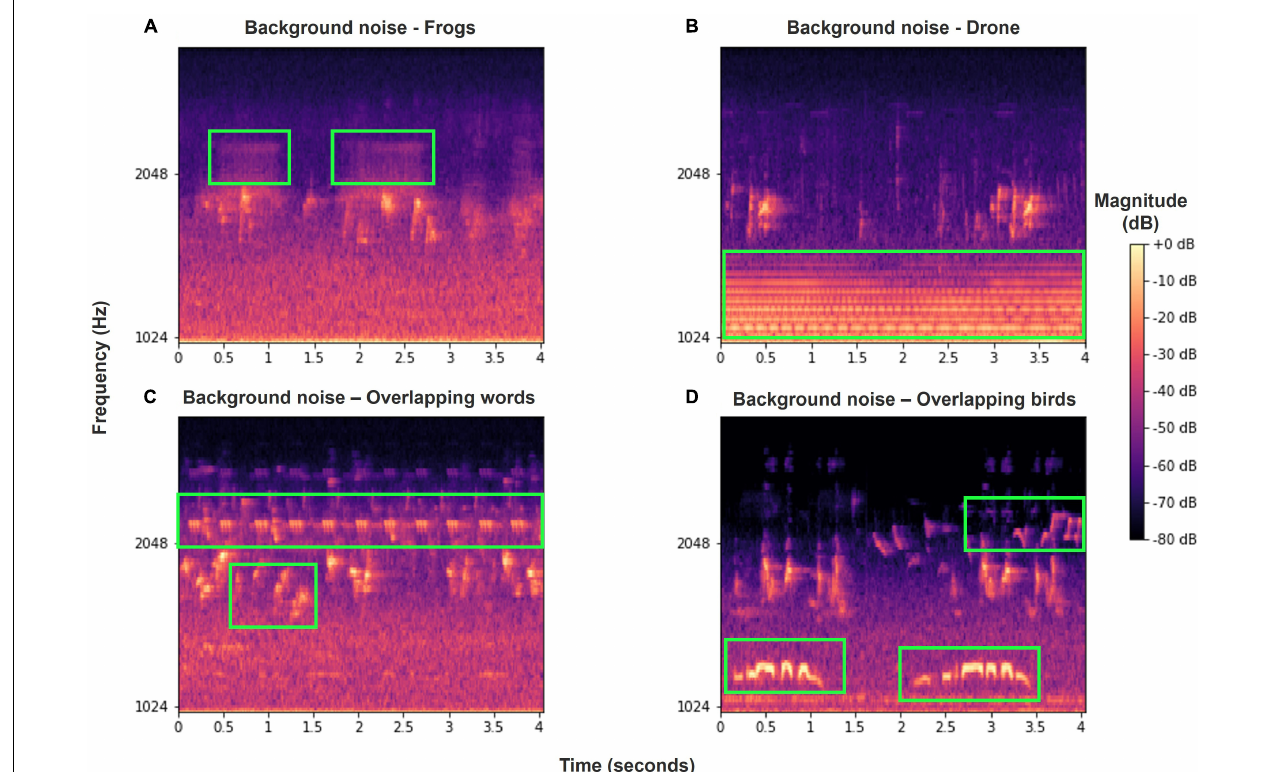
FIGURE 3 | Various examples of background noise or overlapping Bulbul calls in our recordings, marked in green frames. (A) Frog vocalizations; (B) drone sound; (C) overlapping words of other Bulbuls and other birds; (D) overlapping calls of other birds. Most of these noise events are filtered out using our pre-processing